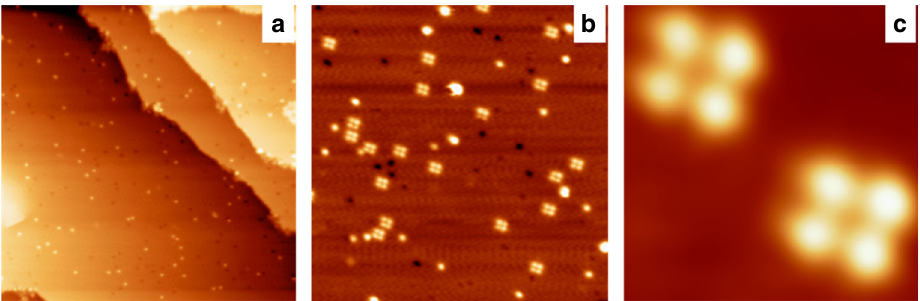
Fig. 2 Formation of tetramers on Cu(100). a The STM image after dosing 0.003ML phenylacetylene molecules on a Cu(100) surface held at 20 K. b The STM image after annealing the sample at 200 K for 20 min. c The high-resolution details of the tetramer features. The image size are 100 nm × 100 nm for a , 40 nm × 40 nm for b , and 4 nm × 4 nm for c . The scanning parameters are V b = 1 V, I t = 50 pA for all the images